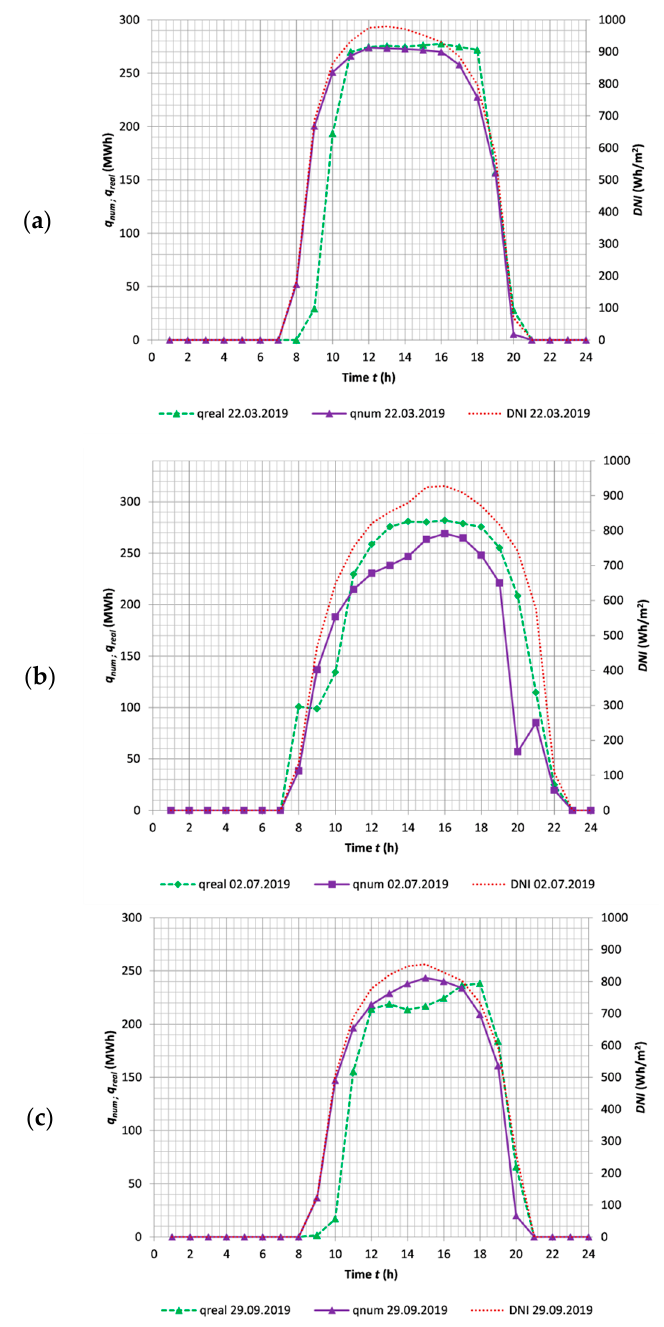
Figure 7. Comparison of heat produced by solar collectors with heat determined from the developed model the Solar Thermal Power Station in Spain for selected days: ( a ) 22.03.2019, ( b ) 02.07.2019, ( c ) 29.09.2019.